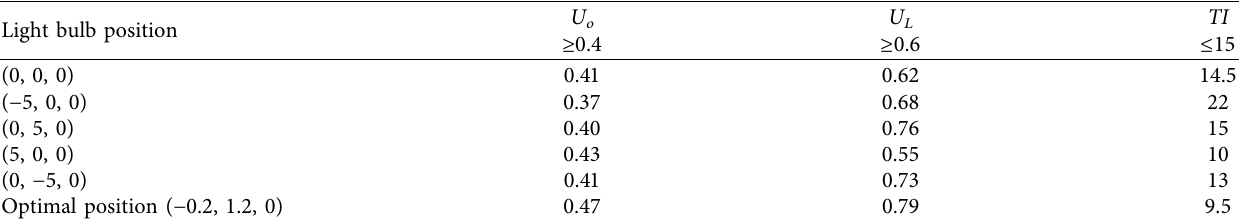
Table 2: DIALux simulation results of the proposed change in light bulb position in the luminaire with respect to the requirements of the CIE M3 class standard.